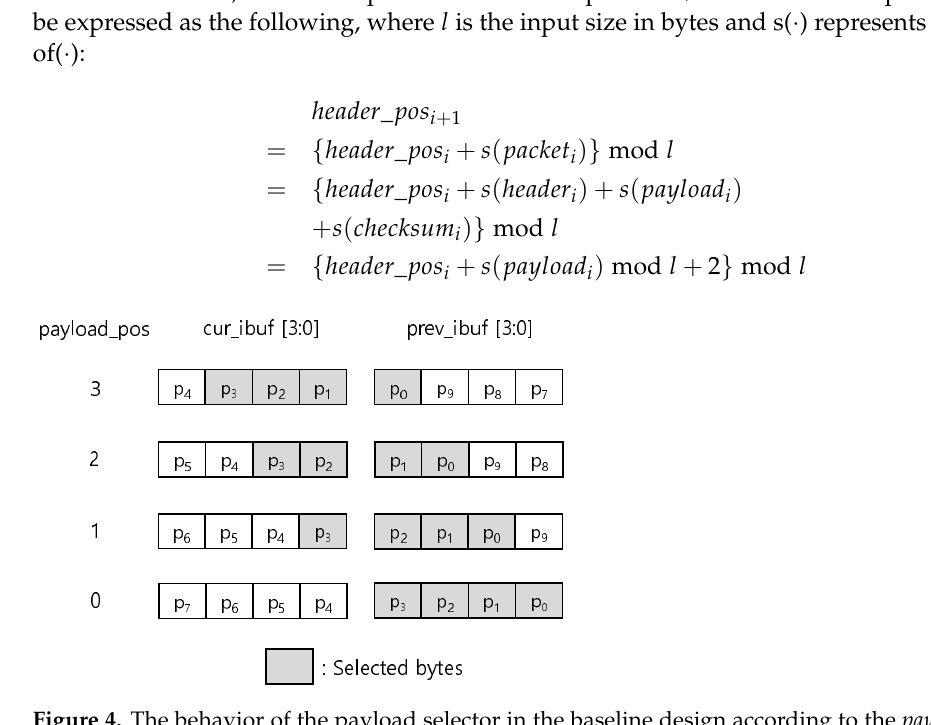
Figure 4. The behavior of the payload selector in the baseline design according to the payload_pos variable, choosing 4 bytes from two input